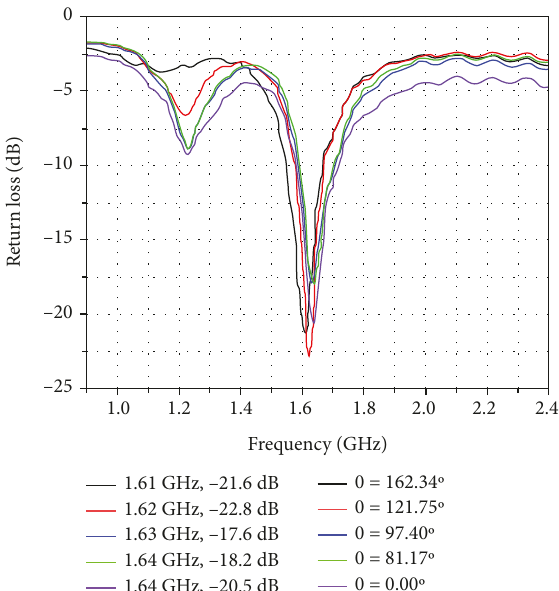
Figure 9: Measured return loss versus frequency plot for textile antenna under bending conditions.